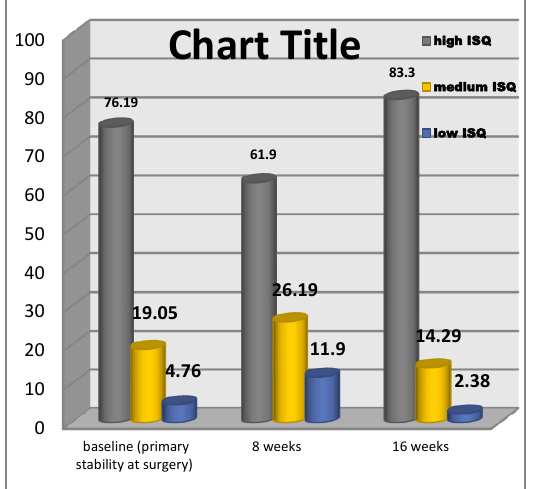
Figure 10: the rate of implants attained high stability (ISQ≥70) & (ISQ>70) at surgery and after 2 successive intervals (8, 16 weeks respectively) (ISQ threshold level ISQ>60 low stability, ISQ 60-70 medium stability, ISQ< 70 high